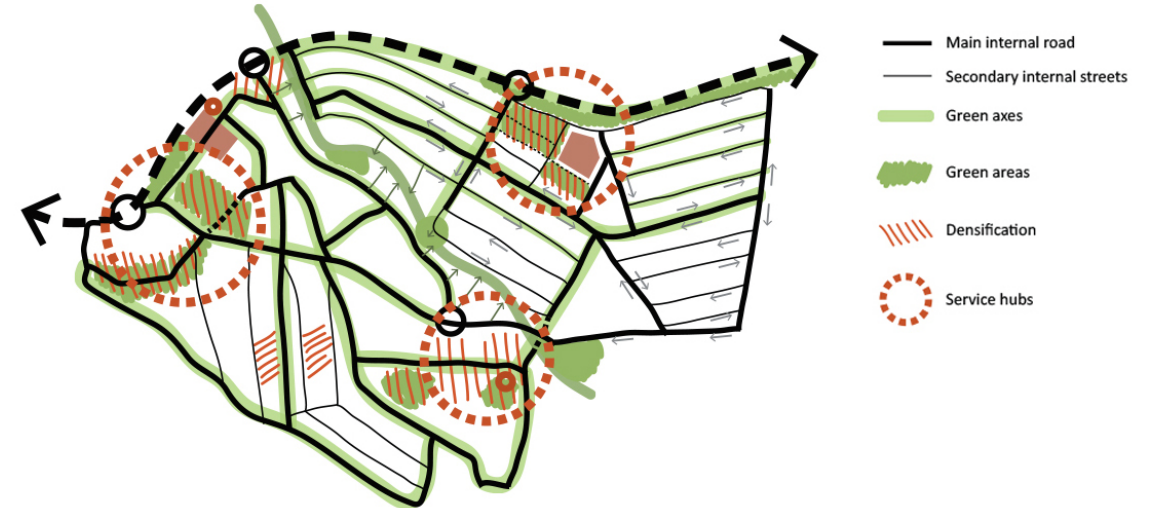
Figure 10. Conceptual proposal for the sustainable transformation of the Pedralbilla-Torre de Portaceli housing estate. Source: Galan